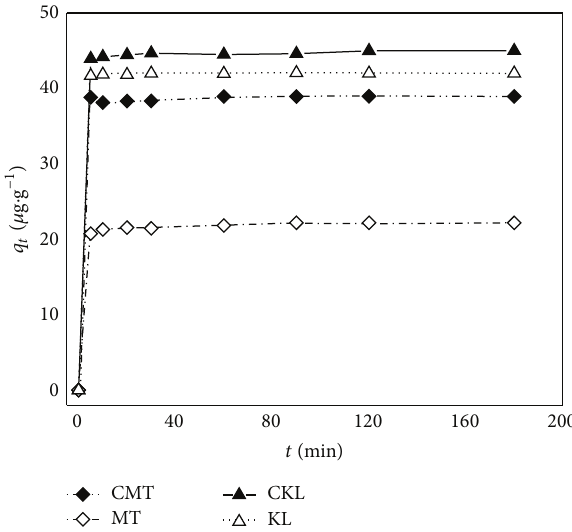
Figure 6: Effect of time on the sorption of pyrene by the bare clays and their complexes at 298